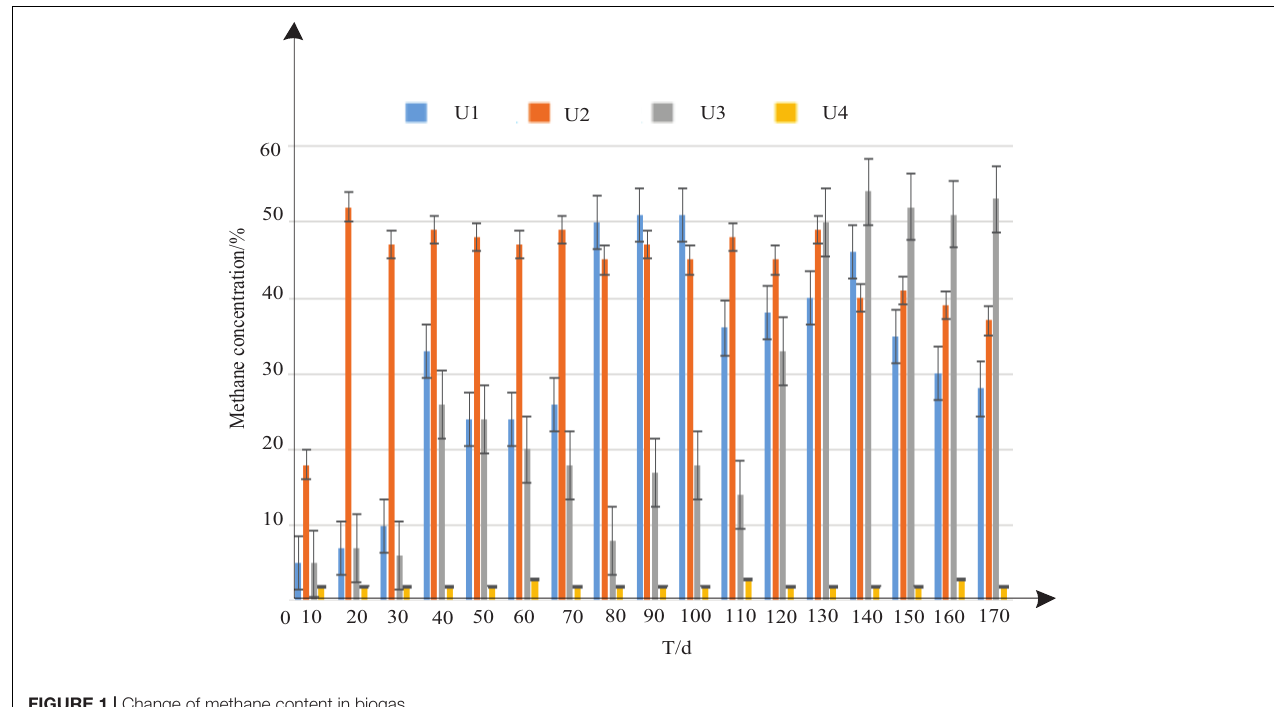
FIGURE 1 | Change of methane content in